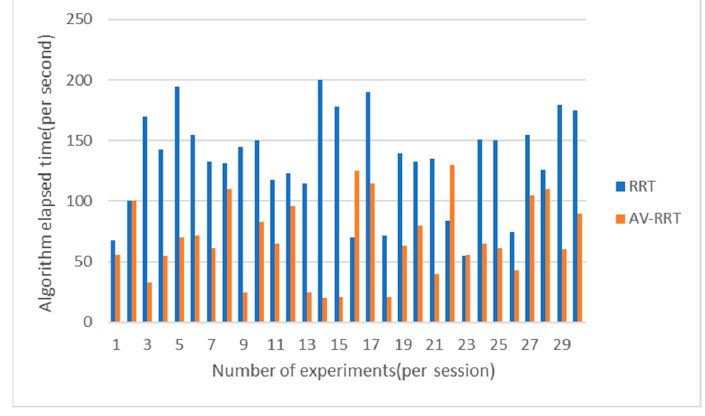
Figure 24. Comparison of consumption of time in the scene with dense obstacles.